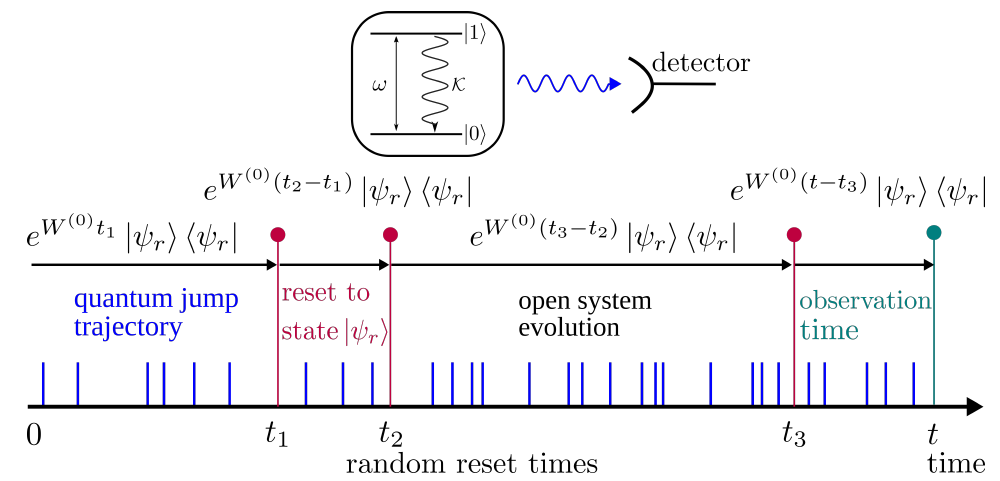
Figure 1: Open quantum system with